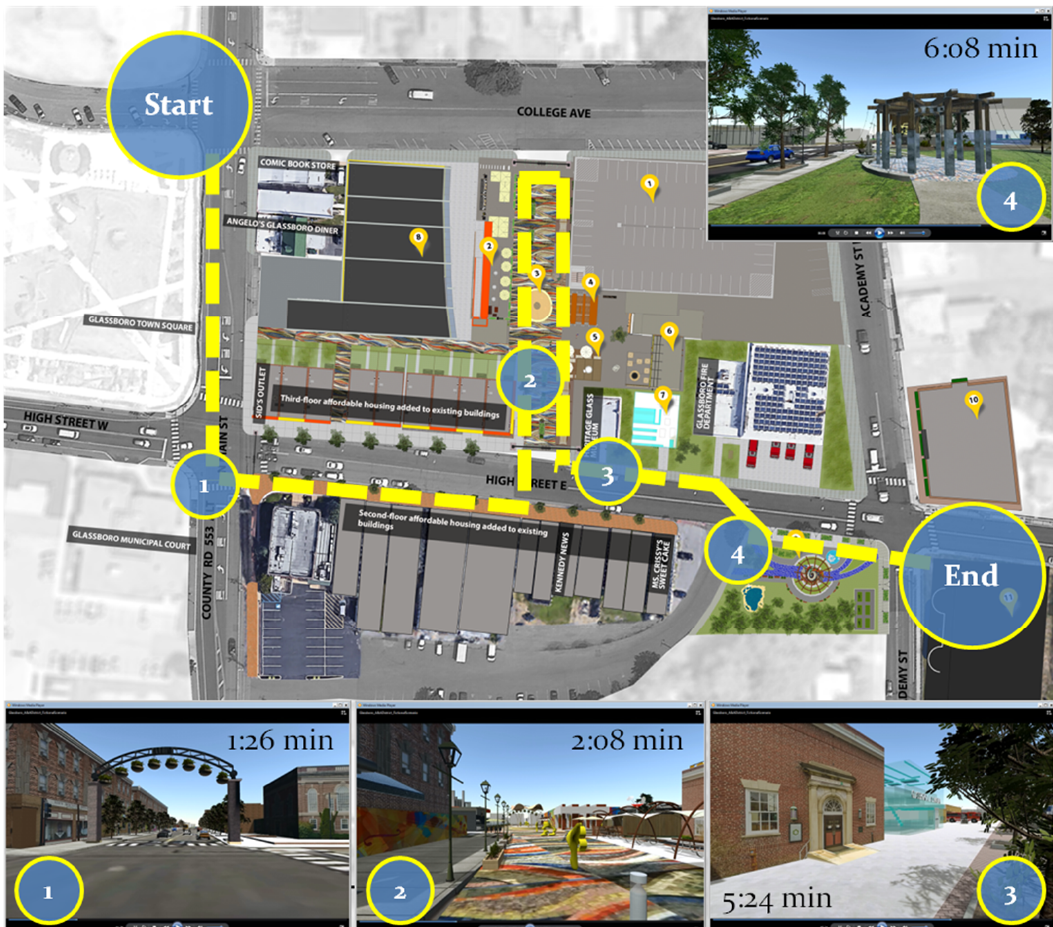
Figure 1. The study area and guided walking path for IVR simulation. Examples of four places / turning points are represented as locations 1, 2, 3 and 4, along with their respective “eye-level” visuals. #1 is the entrance point of High Street—the main walking path of the simulated environment. #2 shows a pedestrian-friendly linear open space with potential vendors, performance stages, and seating arrangements. #3 o ff ers a street-level view of the historic Heritage Glass Museum along with a proposed contemporary glass museum. Finally, #4 represents the entrance of a proposed pocket park (see more details in Figure